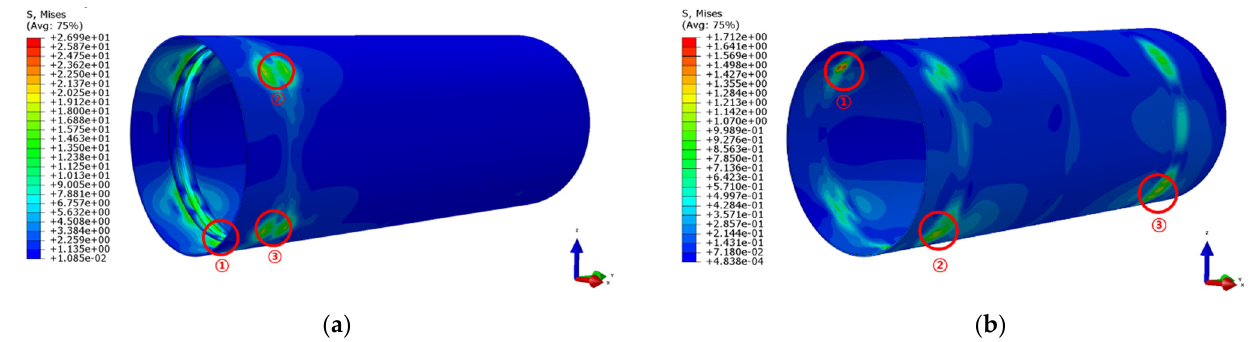
Figure 18. Stress contour in longitudinal acceleration condition for fatigue evaluation: ( a ) SUS304; ( b ) AL-5083-O.